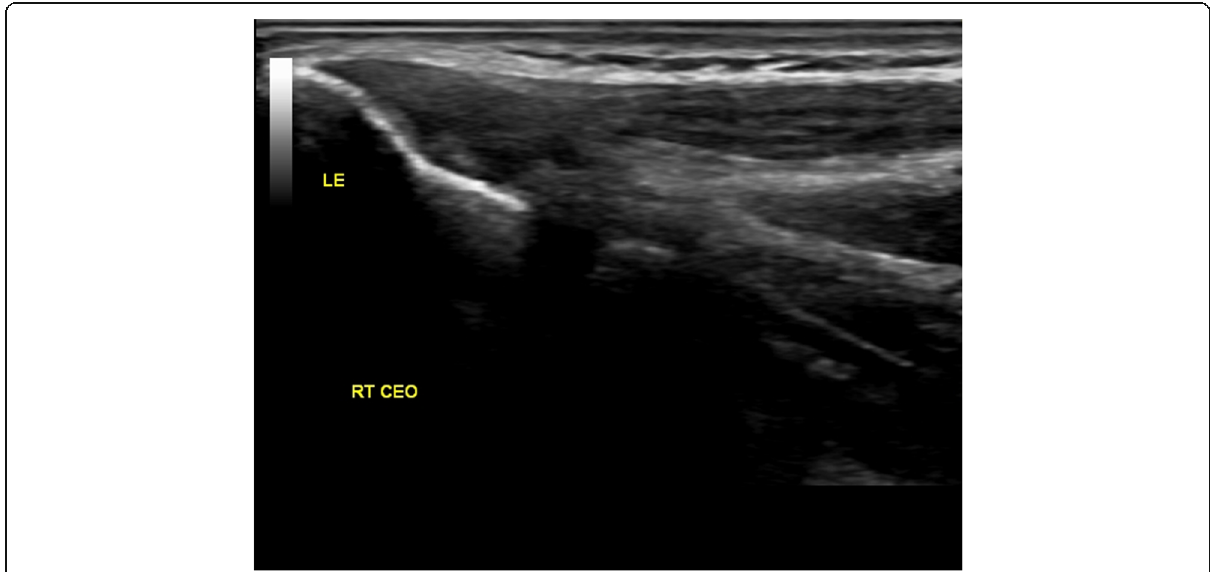
Fig. 2 US picture showing hypoechoic area and disturbed fibrillar pattern of Rt. CEO tendon in a patient before PNI treatment. LE, lateral epicondyle; RT, right common extensor origin